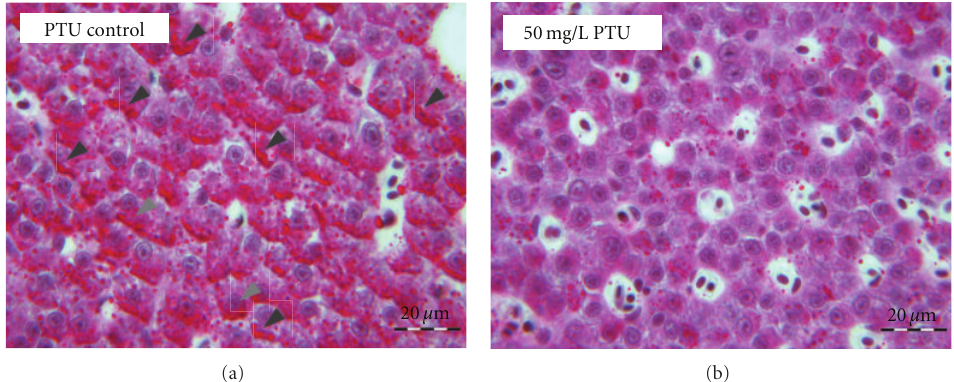
Figure 12: Representative histopathological alterations in hepatocytes of control (a) and PTU-exposed zebrafish (b). The well-visible glycogen deposits in the control ((a): (cid:2) ) are depleted in the higher concentration groups. Sections of 2 μ m thickness stained with periodic acid-Schi ff (PAS) and Mayer’s hematoxylin.